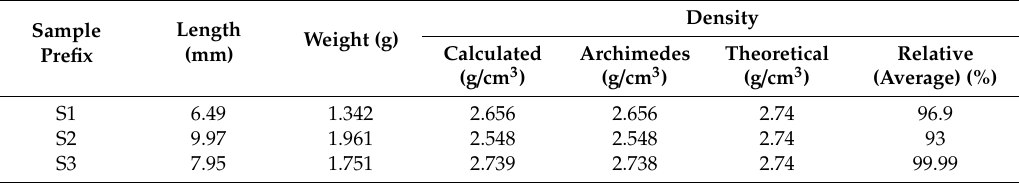
Table 2. Measurements and densities of bulk composites.